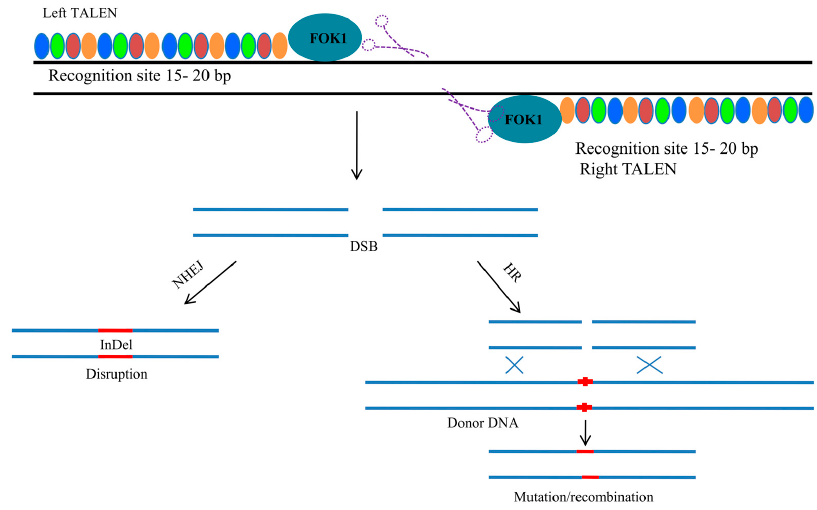
Figure 3. Schematic representation of TALENs (Transcription activator-like effector nucleases) having TALE repeats as shown by colored discs and a FOK1 endonuclease which cleaves the DNA.